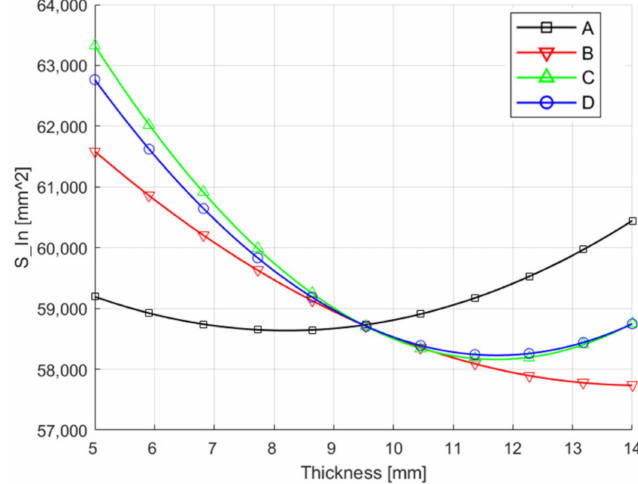
Figure 13. Effect of thickness on S_In response.